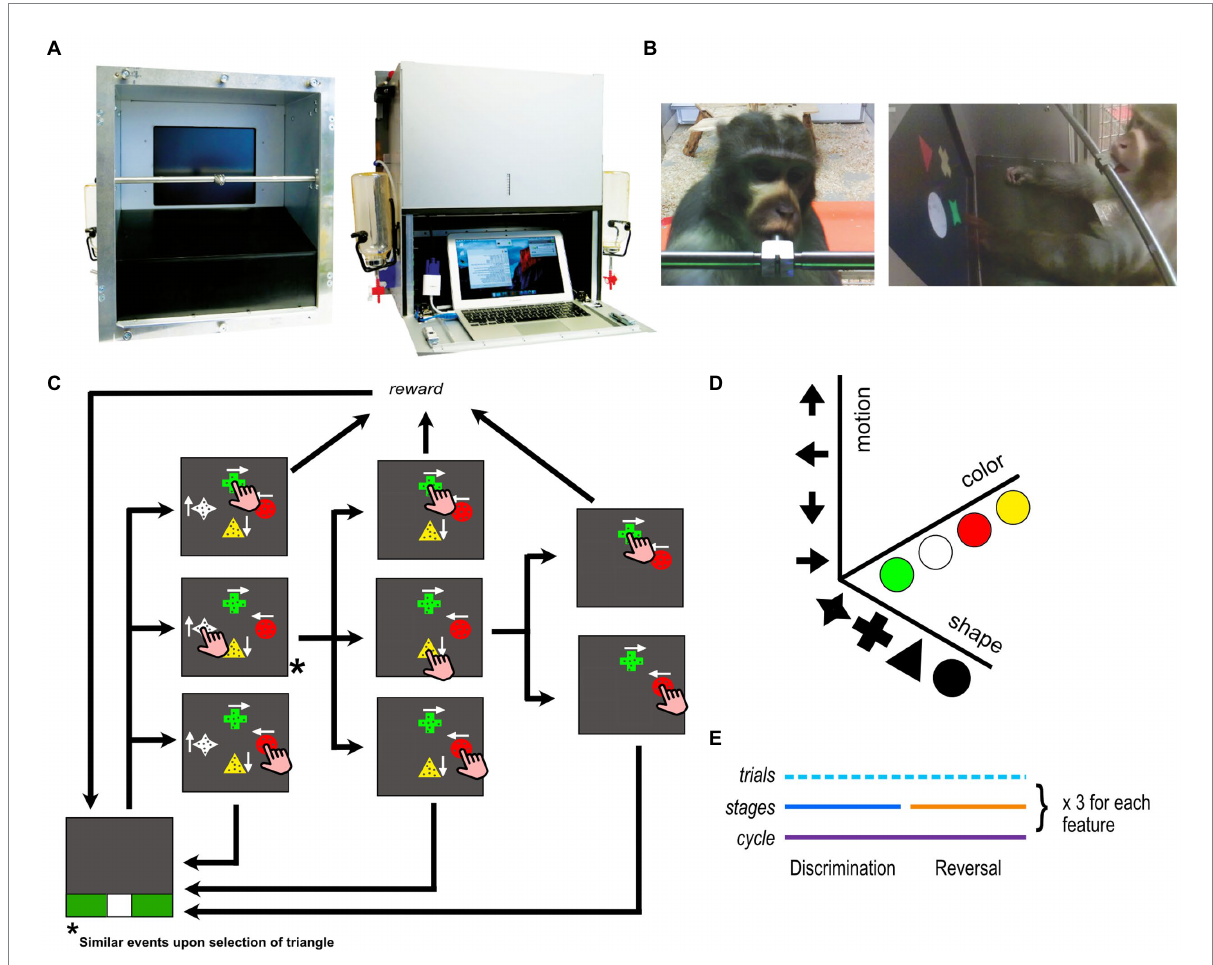
FIGURE 1 Touchscreen device and experimental task. (A) The device seen from the front and the back (B) an animal interacting with the device in his home environment seen through the front and side cameras (C) the task design. In this particular stage, the attended feature is shape with cross being the target and circle the distractor. If target or distractor is touched, the reward is delivered for target selection only but both options terminate the trial. Different auditory feedback is given for target and distractor touches. On the other hand, if one of the neutral stimuli (star or triangle in this case) is selected, it disappears and the trial continues until either a target or a distractor is chosen as illustrated in the figure. For the sake of simplifying the figure, the sequence of events for selecting a triangle is not illustrated in the figure but the trial would continue in a similar fashion as in the case for the selection of star (D) the three feature dimensions used in the experiment (E) the timeline of a complete assessment